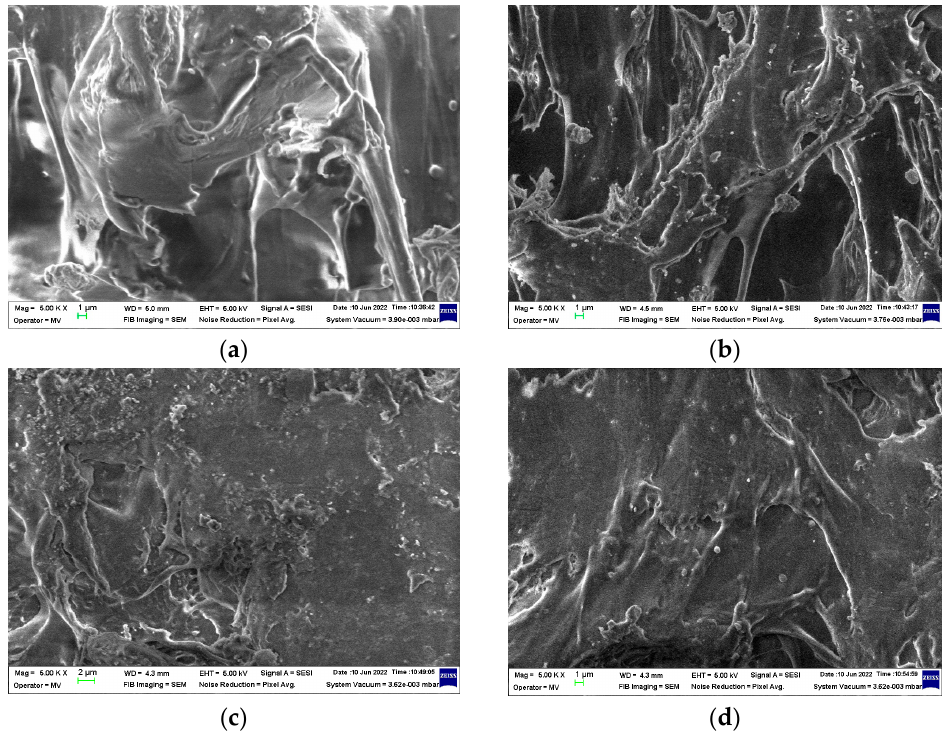
Figure 10. The SEM images on nonirradiated PLA/SIS 30 samples. Compositions: ( a )